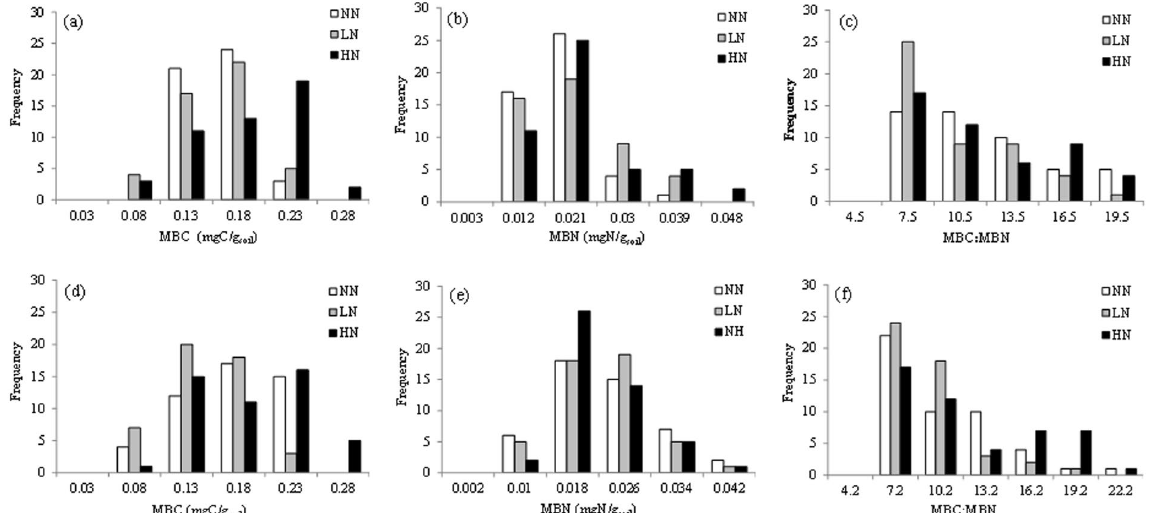
Figure 2. Frequency histograms of soil MBC, MBN concentrations and MBC:MBN under three fertilization treatments (i.e. NN, LN and HN) in SG (panels a~c) and GG (panels d~f) croplands in a three-year long fertilization experimental site at the Tennessee State University (TSU) Agricultural Research Center in Nashville, TN, USA. The number on the x-axis (i.e. 0.03, 0.08 in panel a) represents a range of (0, 0.03) and (0.03, 0.08), respectively. The abbreviations are referred to Table